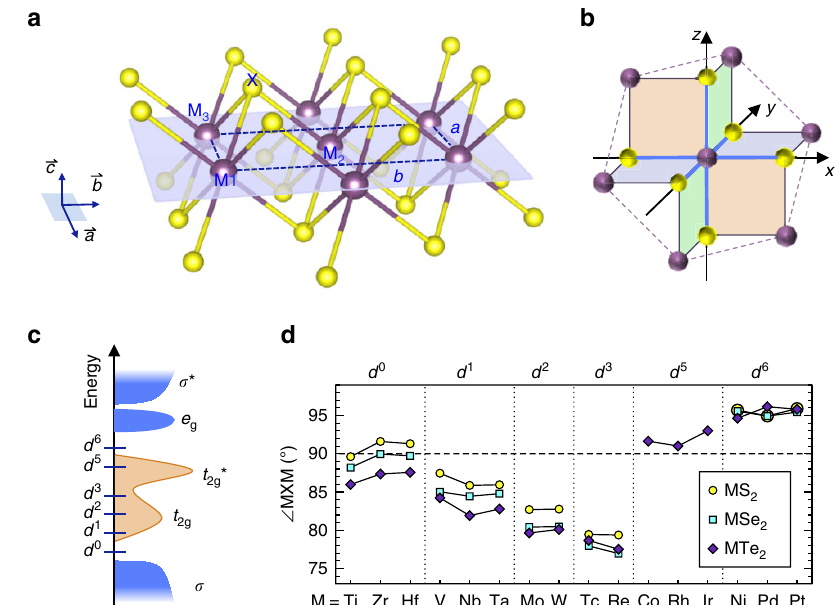
Figure 1 | Structure of monolayer 1T-MX 2 . ( a ) Crystal structure. The basic X-M 1 -M 2 -M 3 triangular pyramid unit is marked. The rectangular outline displays the unit cell adopted in our calculation. It contains two MX 2 formula units. ( b ) Local structure of M-centred octahedron. The metal atoms form three one-dimensional chains in the directions of y ¼ x , z ¼ y and z ¼ (cid:2) x in the local reference frame. The M–M interaction is through the t 2g -orbital coupling. ( c ) Schematic configuration of DOS showing the gradual filling of d orbitals from group 4 ( d 0 ) to group 10 ( d 6 ) 1T-MX 2 . The horizontal bars denote the corresponding Femi level of the system. t 2g and t 2g * correspond to the intermetal t 2g -bonding and t 2g -antibonding states, respectively. ( d ) Predicted M–X–M bond angles in the relaxed structure of strain-free 1T MX 2 . Note, in the triangular pyramid as shown in Fig. 1a, +